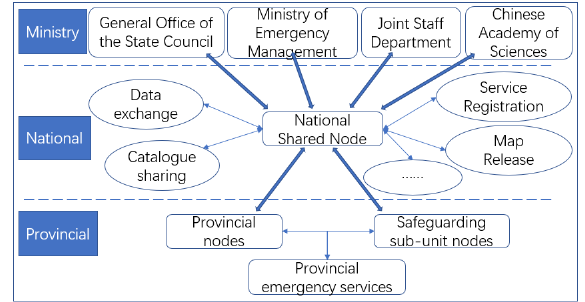
Figure 1 . Basic idea of shared